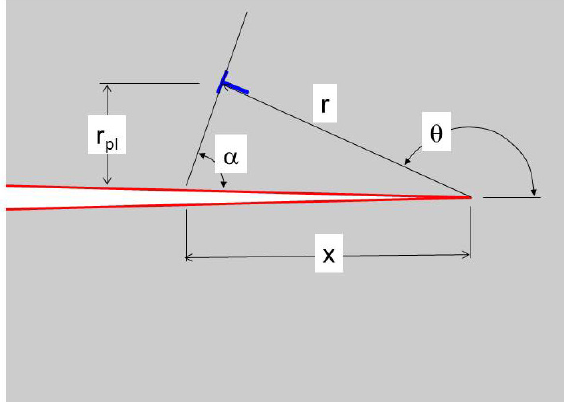
Figure 4: Schematic representation of the geometrical arrangement of a single dislocation generated during the compression